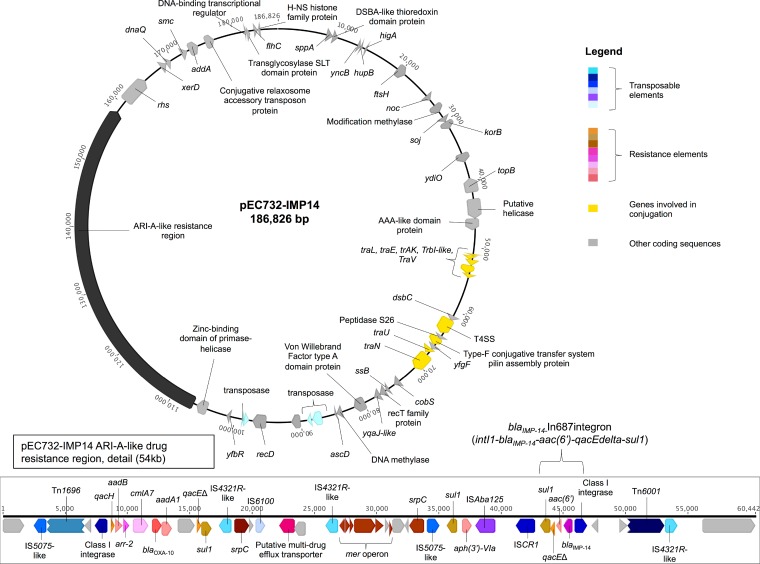
Plasmid pEC732-IMP14 with a detailed view of the ARI-A-like 54-kb resistance region (bottom).